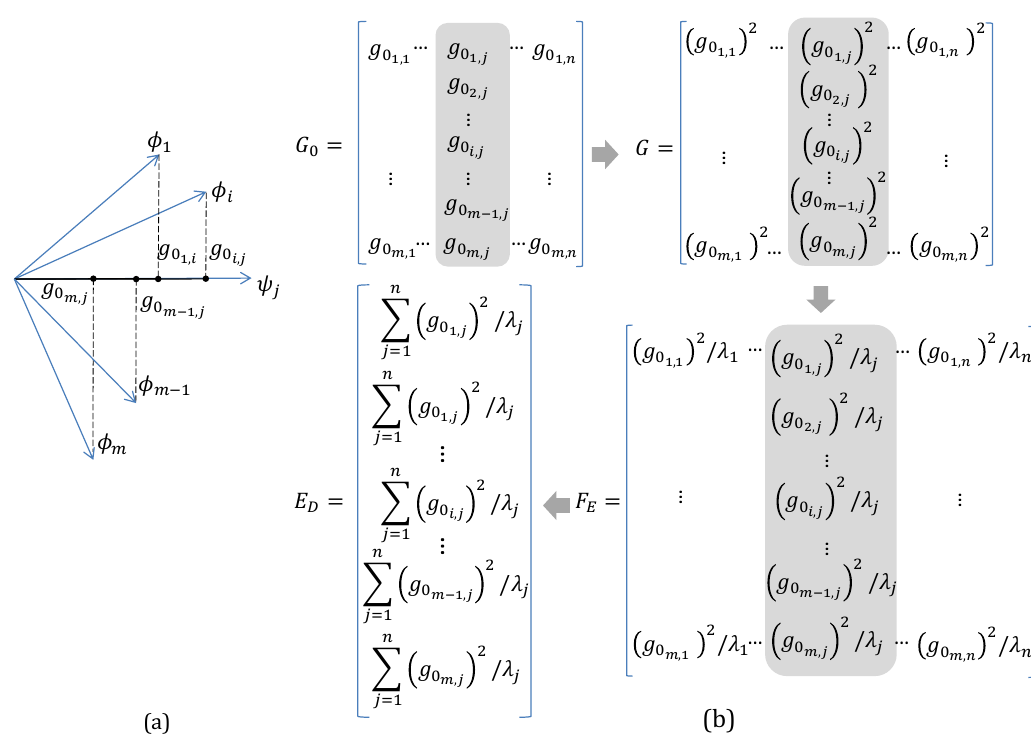
Figure 2. Determination of the Effective Independence (EI) distribution for the sensor set used for the target modes: ( a ) Projection of row vectors of Φ s on a given column vector ψ j of Ψ ; ( b ) Operations involving matrices G 0 , G and G λ for the generation of vector E D